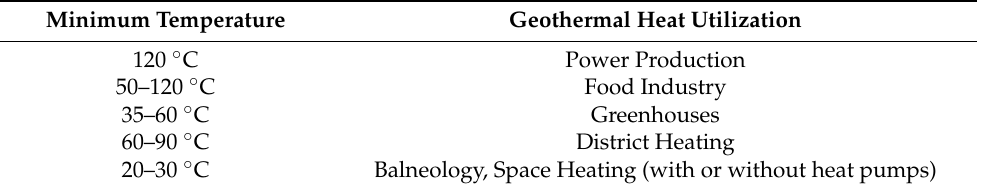
Table 3. Minimum temperatures for geothermal applications in